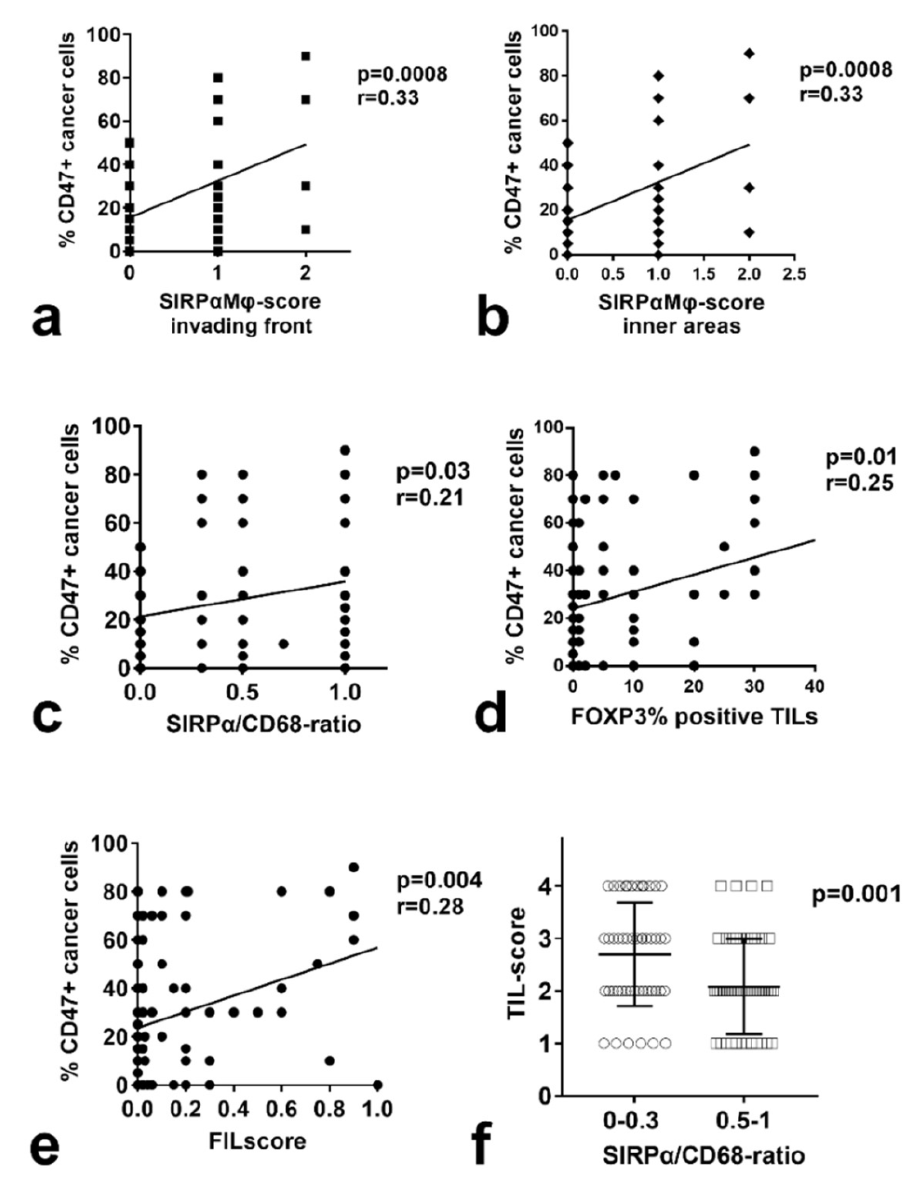
Figure 4. Association between CD47, SIRP α , CD68, and immunological parameters: ( a , b ) linear regression analysis between CD47 expression by cancer cells and SIRP α -M ϕ score in the invading tumor front and inner tumor areas; ( c ) linear regression analysis between CD47 expression by cancer cells and SIRP α /CD68-ratio; ( d ) linear regression analysis between CD47 expression by cancer cells and the percentage of FOXP3+ TILs; ( e ) linear regression analysis between CD47 expression by cancer cells and FIL-score; ( f ) TIL-score distribution in two SIRP α /CD68-ratio